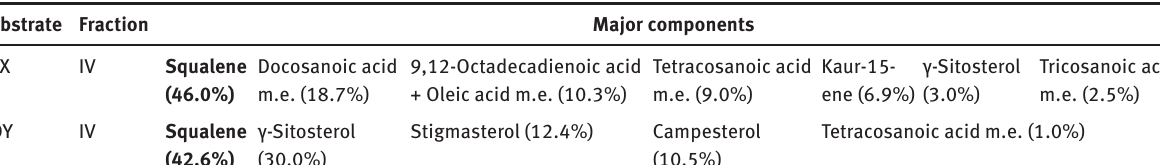
Table 4: Percentage composition of the squalene-enriched